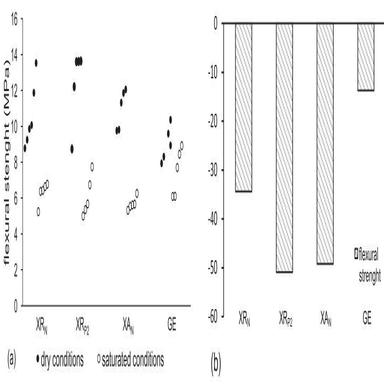
(a) - individual specimens ftc results; (b) – ftc dry to sat variation.